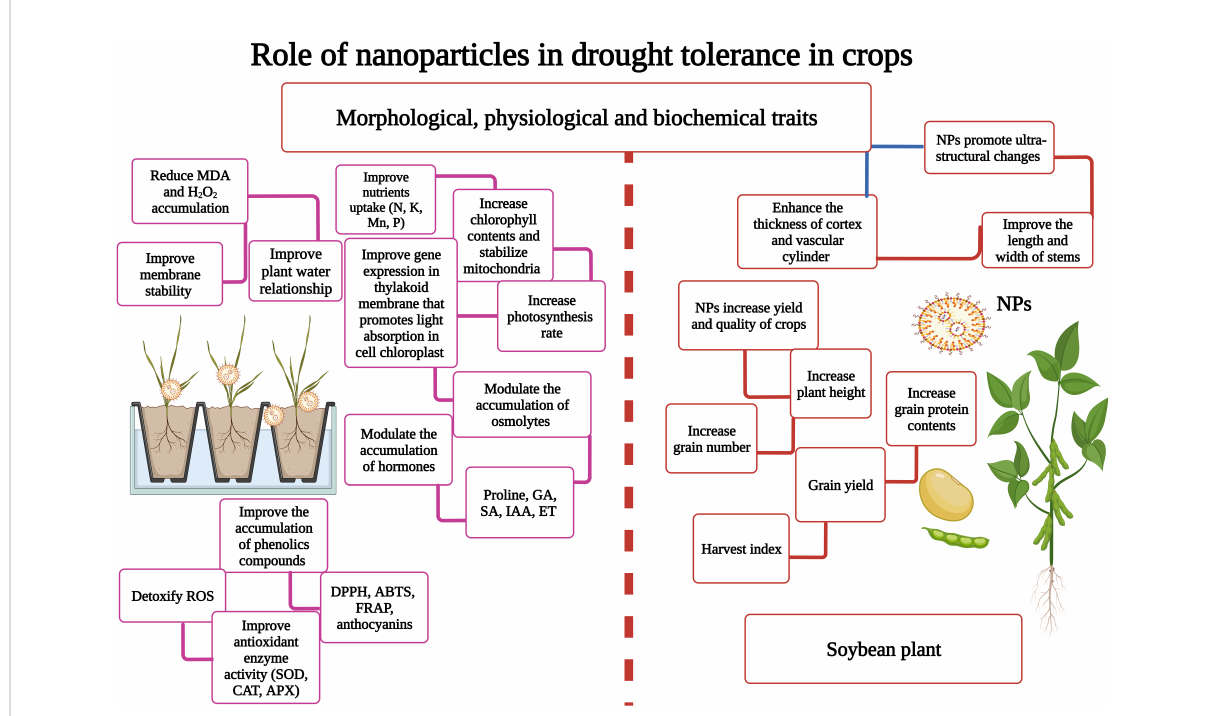
FIGURE 2 Nanoparticles (NPs) play a key role in enhancing drought stress (DS) tolerance in plants. NPs reduce MDA accumulation, maintain membrane stability, induce the expression of stress-related proteins, improve nutrient and water uptake, increase photosynthesis, and increase grain yield and harvest index. This Figure is created with